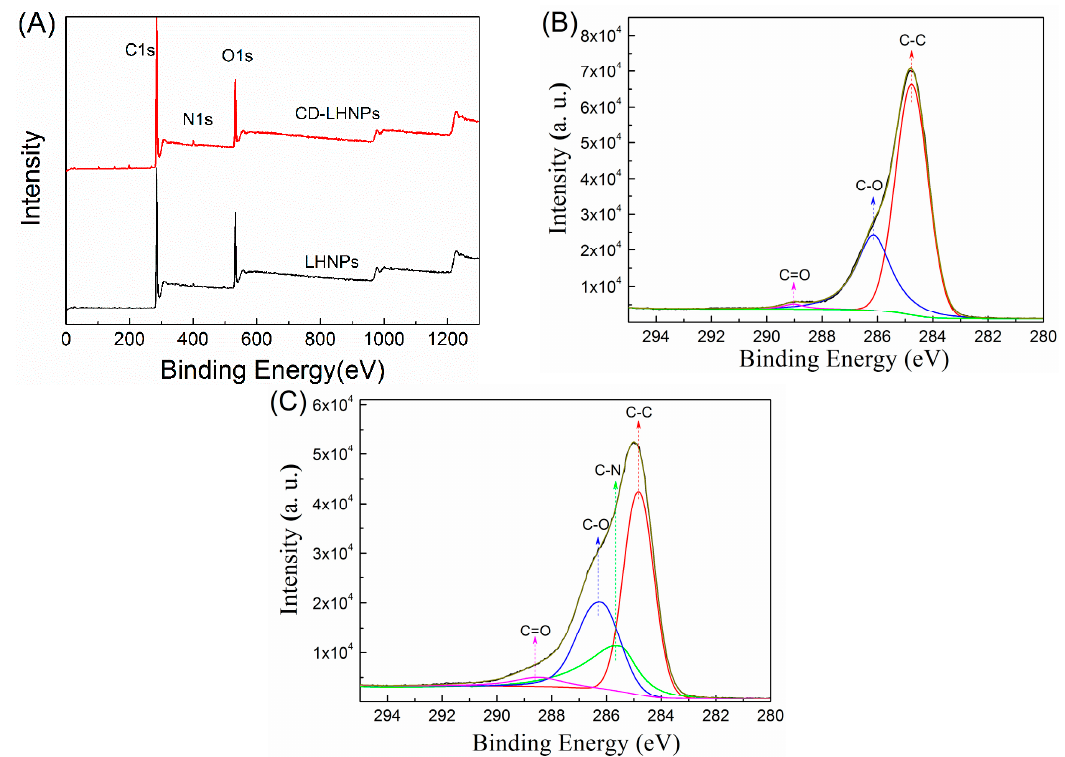
Figure 4. XPS scans of LHNPs and CD-LHNPs. ( A ) XPS wide scans of the LHNPs and CD-LHNPs, ( B ) deconvolution of C1s signals for the LHNPs and ( C ) deconvolution of C1s signals for the CD-LHNPs. Table 1. Elemental distribution of LHNPs and CD-LHNPs, and their outer surfaces.